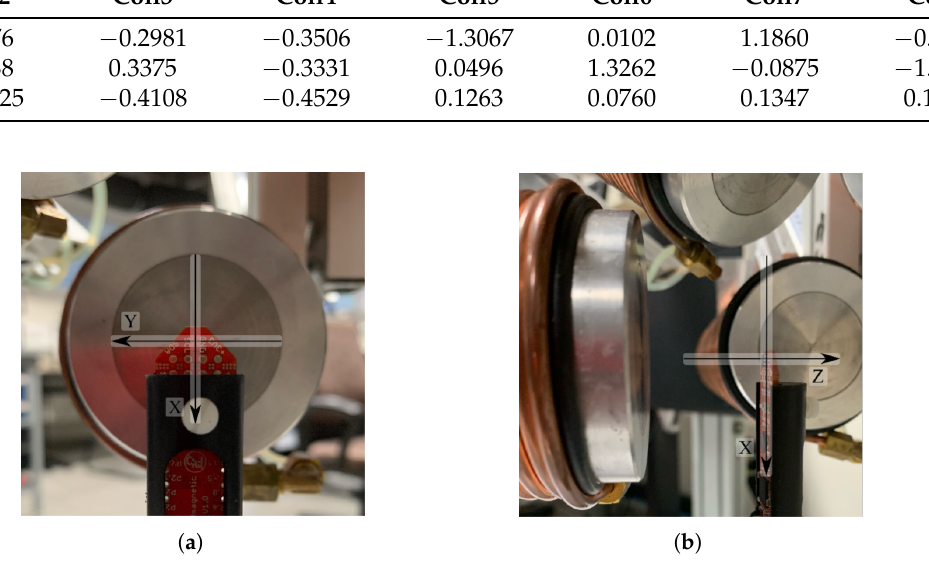
Figure 23. The definitions of the magnetic directions x , y and z of the sensor TLE493D-W2B6. ( a ) The front view of the magnetic sensor; ( b ) the side view of the magnetic sensor.